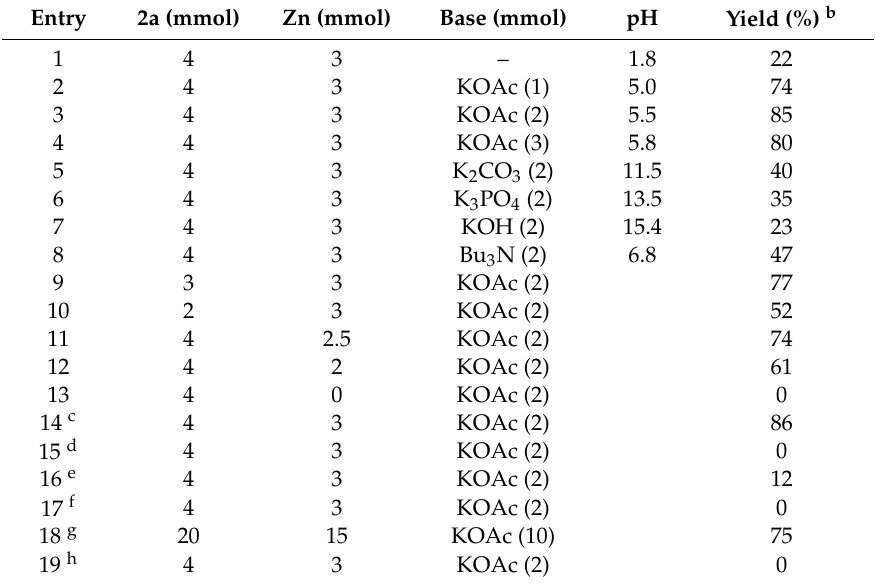
Table 1. Iron-catalyzed conjugate addition of iodobenzene ( 1a) onto n -butyl acrylate ( 2a ) a .